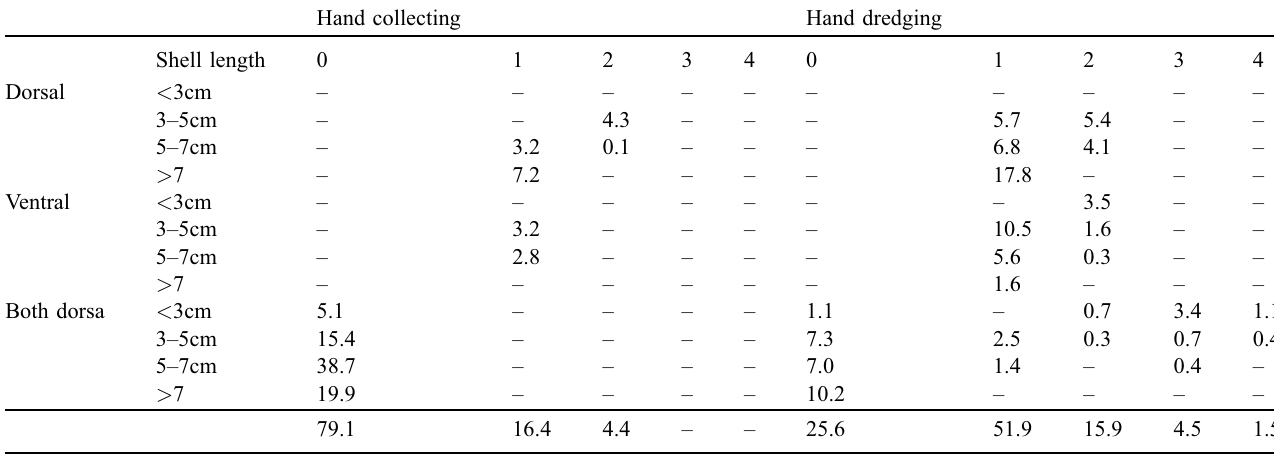
Table 1. In fl uence of specimen size (hard clam shell length subdivided into four size classes) on the damage frequency and degree in fl icted by hand collecting and hand